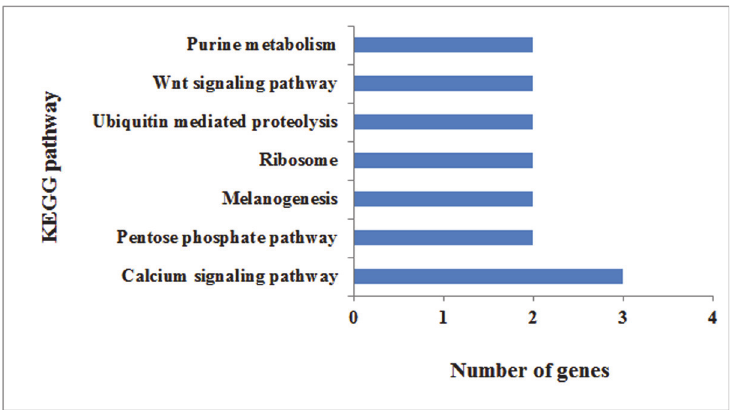
Fig 4. KEGG pathways of the low methylation genes. Those pathways involving more than two genes were selected for mapping and are listed according to the number of